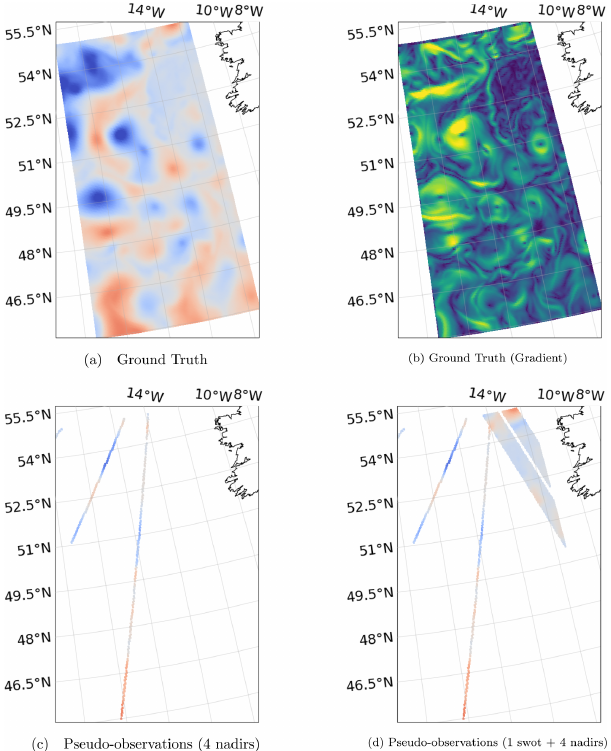
Figure 4. NATL60 ground truth (a) and its gradient (b) . Panel (c) shows 1d accumulated along-track four nadirs, and wide-swath SSH pseudo-observations plus four nadirs are shown in panel (d) , both for 25 October 2012 (GULFSTREAM domain).